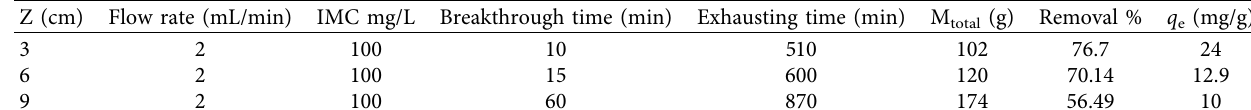
Table 2: Performance of the column under different depths.